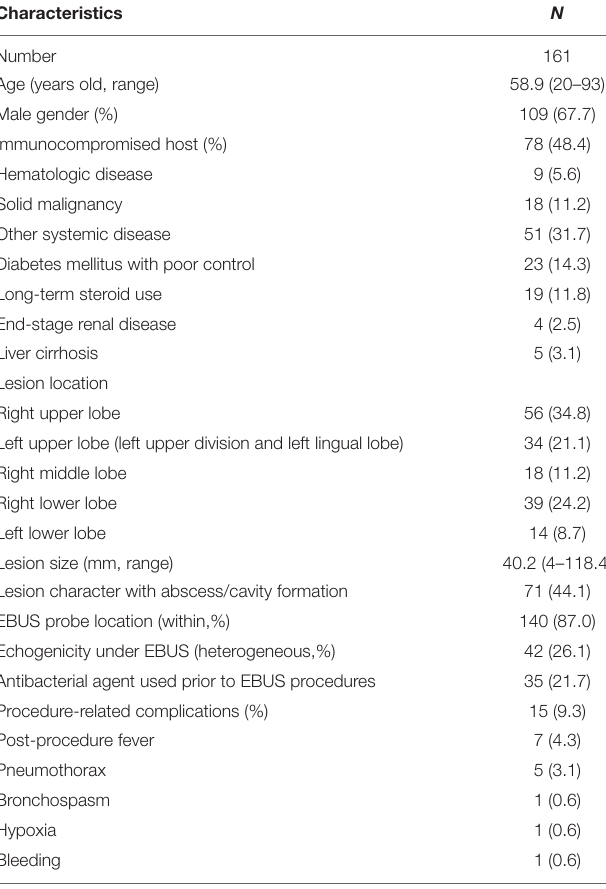
TABLE 1 | Characteristics of the patients, target lesions, and endobronchial ultrasound (EBUS) procedures. Characteristics